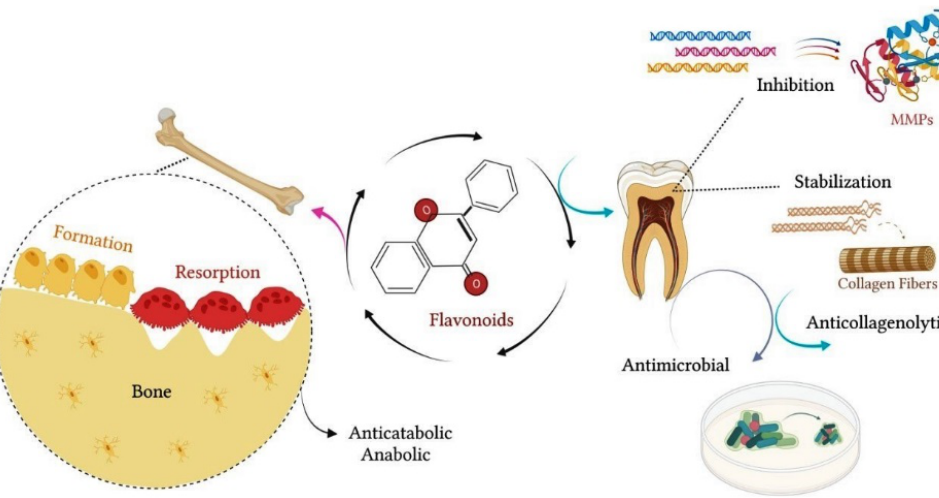
Figure 4 schematizes the main effects of flavonoids on mineralized tissues.